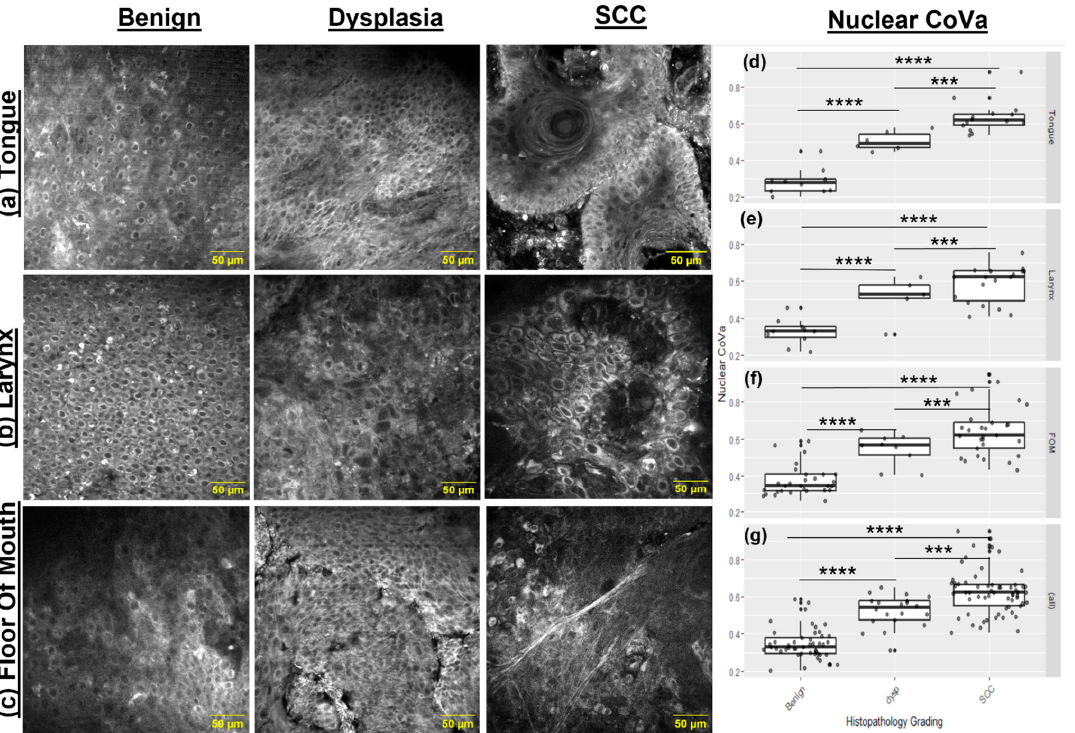
Figure 4. Representative, single mid-layer micrographs of ( a ) tongue, ( b ) larynx, and ( c ) floor of mouth and respective pathological grading (benign, dysplasia, and SCC). Benign regions displayed an organized cellular structure. Dysplastic regions showed some nuclear atypia, with some variable nuclear shape and size. SCC presented the most variation in nuclear shape, as noted in panels ( d – f ). Panel ( g ) shows all grouped diagnostic samples, regardless of anatomical site. Scale bar, 50µm for optical slices, Kruskal–Wallis test with subsequent Dunn’s test, p -value < 0.0001 = ****, and p - value < 0.001 = ***. Dunn’s test, p value.